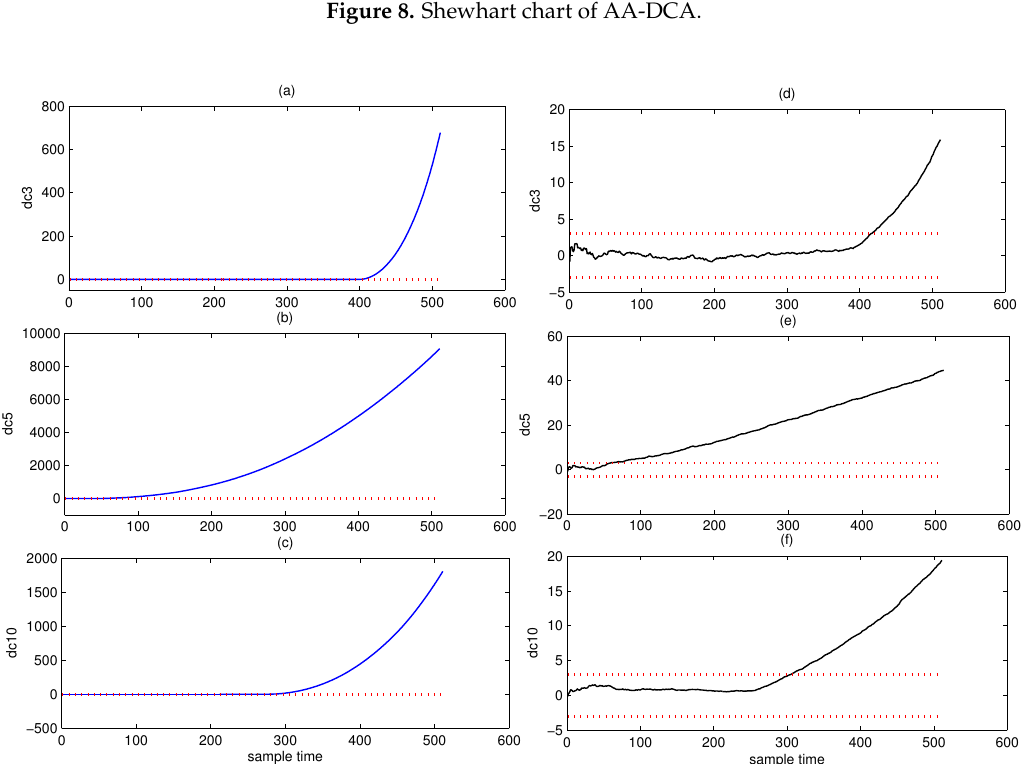
Figure 9. Shewhart to D 3 , D 5 or D 10 for CUSUM-AA-DCA. The subfigures ( a – c ) are the Shewhart charts to D 3 , D 5 , or D 10 of CUSUM-AA-DCA. The subfigures ( d – f ) are the Shewhart charts to D 3 , D 5 , or D 10 of AA-DCA. The dotted red line is the control